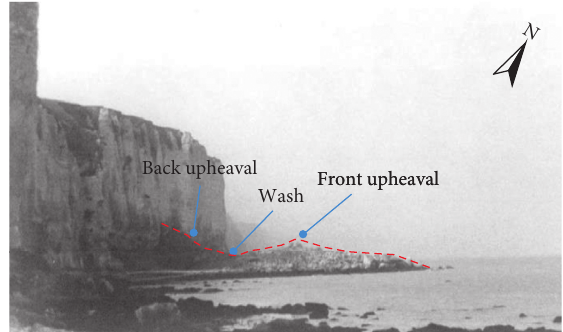
Figure 11: Flowslide occurred in May 1981 at Le Chien Neuf